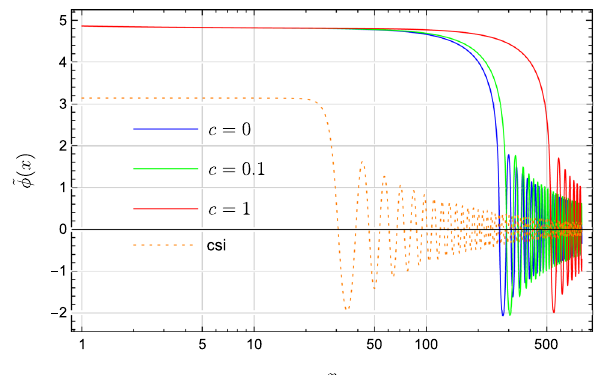
Fig. 2 This plot shows the time evolution of ˜ φ in RD